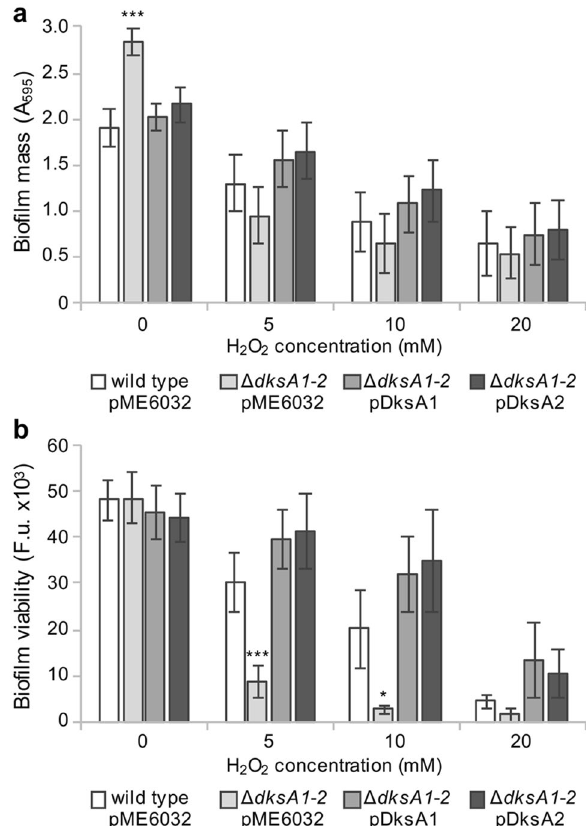
Figure 2. Effect of dksA paralogs on H 2 O 2 tolerance in P. aeruginosa biofilm. Biofilm biomass ( a ) and viability ( b ; expressed as Fluorescence units, F. u.) of the indicated strains grown in M9-glu-CAA supplemented with 0.1 mM IPTG, challenged for 6 h with 5, 10 or 20 mM H 2 O 2 . The average values from five independent experiments performed on multiple wells per condition are reported with standard deviations. *** p < 0.001 versus untreated wild type (a; ANOVA); * p < 0.05 and *** p < 0.001 versus wild type challenged with 10 and 5 mM H 2 O 2 , respectively ( b ;